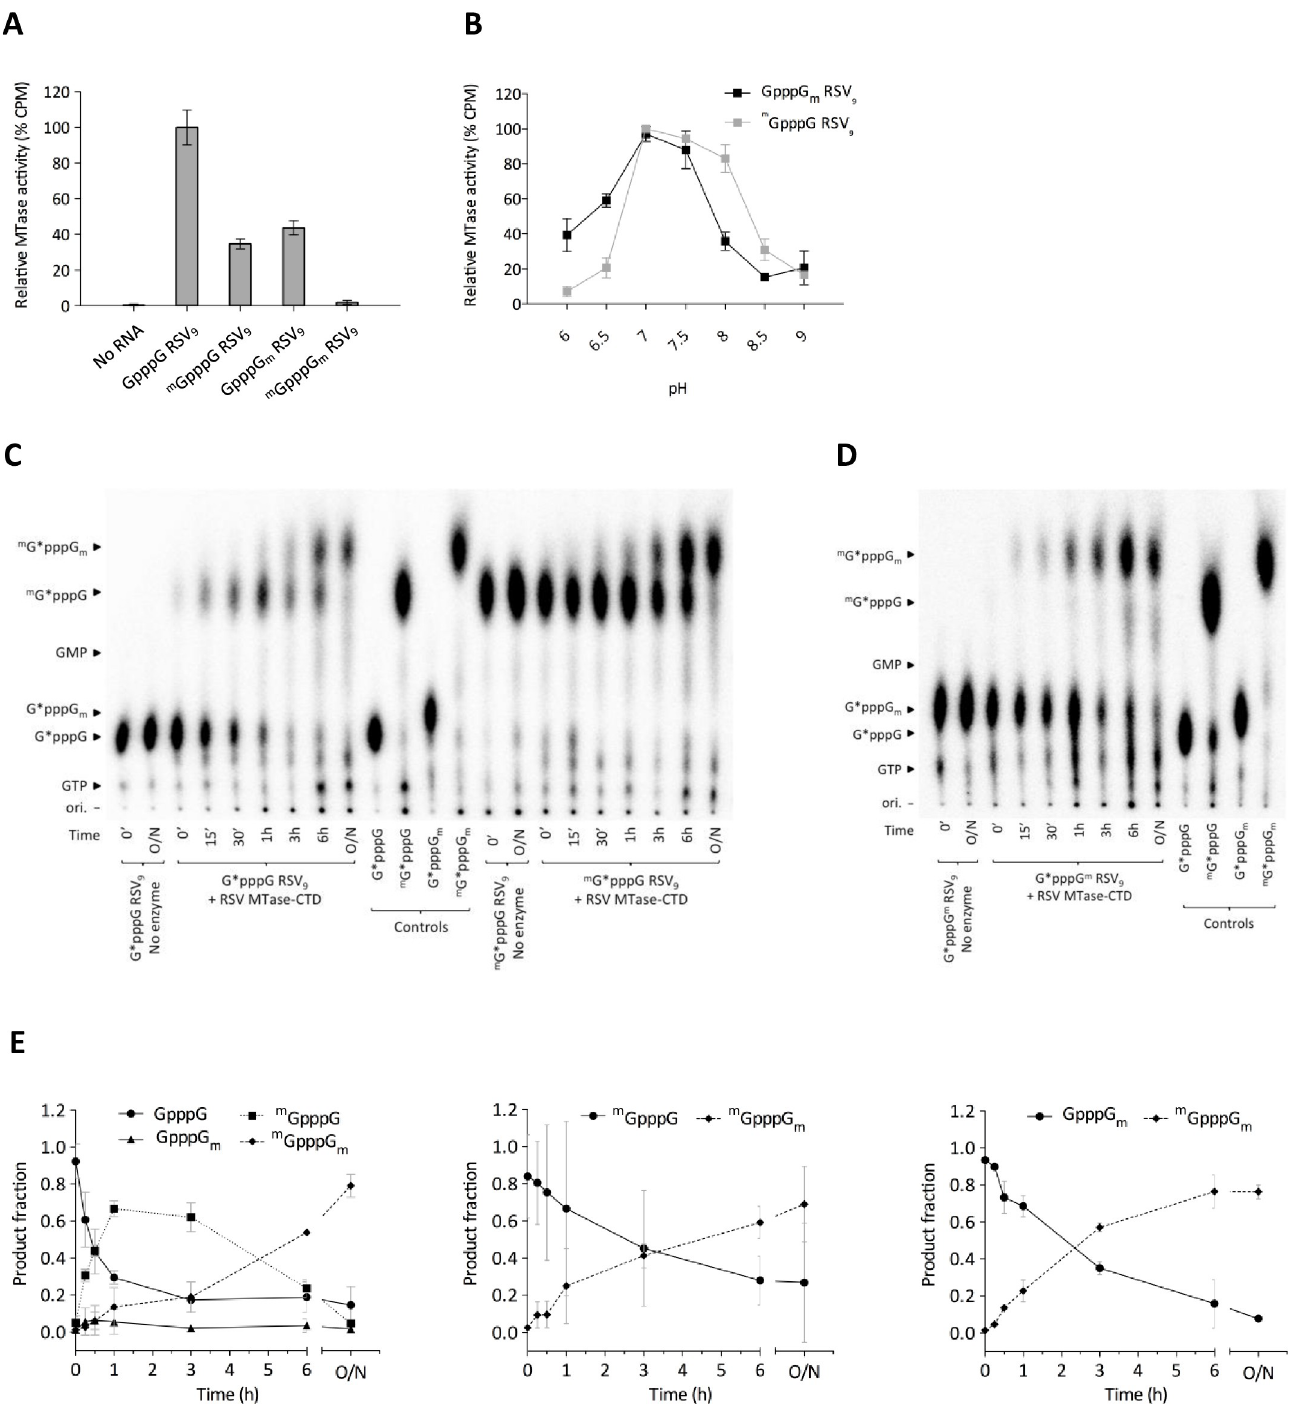
Fig 5. N7- and 2’- O -methylation activity of the RSV MTase-CTD protein. ( A ) MTase activity measurements by filter-binding assay using capped RSV 9 RNAs (GGG ACA AAA). Values were normalized to the activity on Gppp GGG-RSV 9 and are the mean ± SEM ( n = 3). ( B ) Time-course of N7- and 2’- O -methylation activities on GpppG m and m GpppG RSV 9 RNAs, respectively, by the RSV MTase-CTD protein (25 nM) measured by filter-binding assay at different pH (from 6.0 to 9.0). The plotted values were obtained after 3 h incubation at 30˚C. Values were normalized to the maximum activity on each substrate and are the mean ± SEM ( n = 3). ( C, D ) Thin-layer chromatography analysis of cap structures of control RNAs and substrates (G � pppG (C left), m G � pppG (C right), G � pppG m (D)) incubated with the RSV MTase-CTD ( � indicates G( 32 P)-labeled). Nucleotides 2–9 were removed by nuclease P1 digestion and caps were separated using 0.65 M LiCl as mobile phase. Controls (G � pppG, G � pppG m , m G � pppG, m G � pppG m ) were obtained using the pppG-RSV 9 substrate and vaccinia virus MTases that